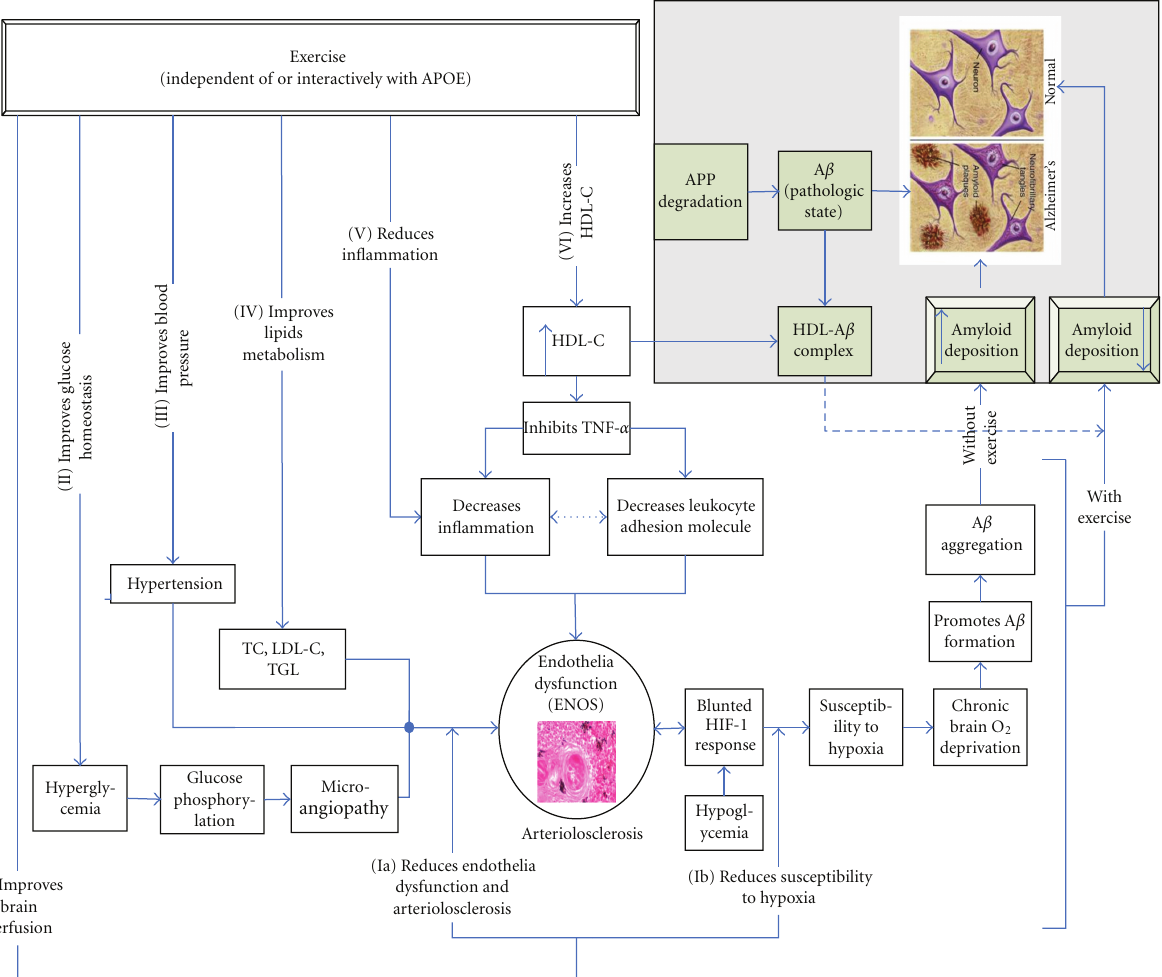
Figure 2: Interaction of HDL-C with AD risk factors. Relationships of exercise to prevention of intracerebral amyloid deposition.